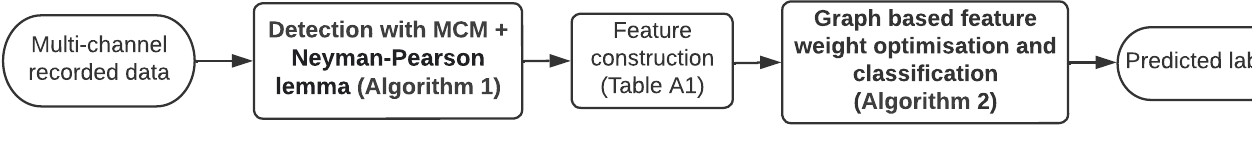
Figure 1. Workflow of the proposed system. The proposed Algorithms 1 and 2 are in